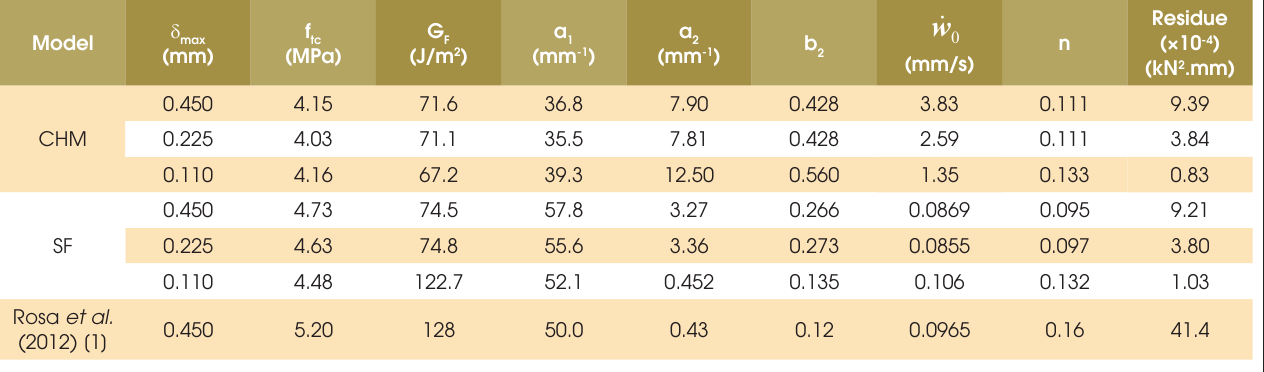
Table 8 – Results of the simultaneous fit of the viscous-cohesion using the Bilinear cohesive model